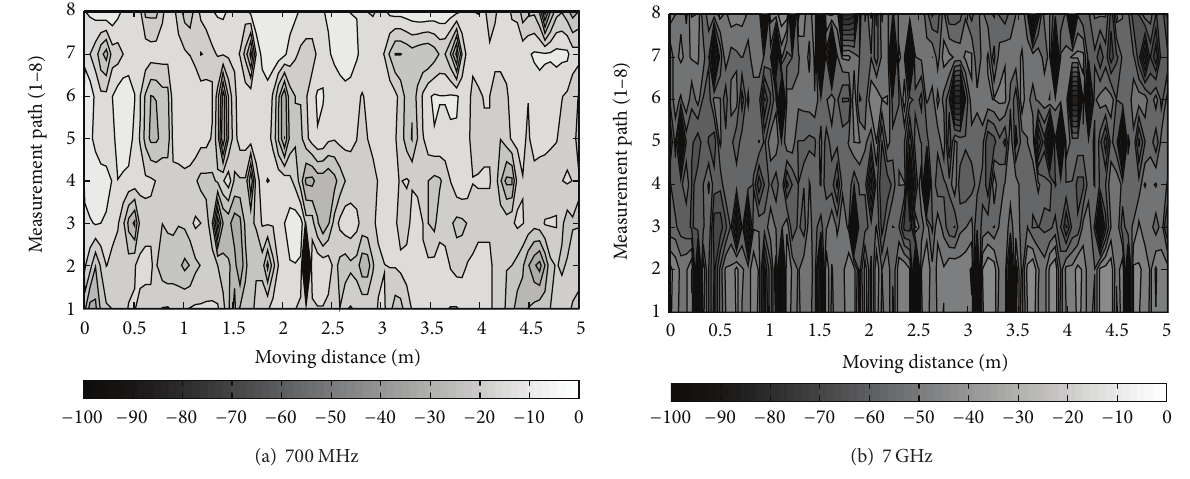
Figure 5: Measured received signal strength (fading effect).